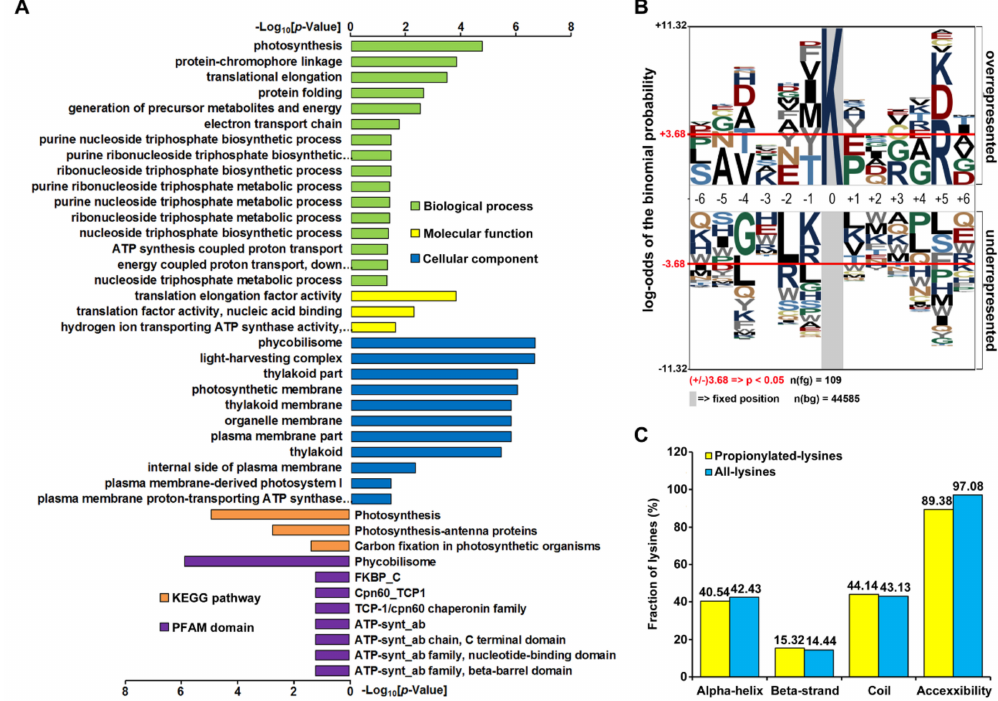
Figure 2. Enrichment analysis of propionylated proteins and bioinformatics analysis of propionylation sites. ( A ) Histogram representations of the enrichment of propionylated proteins according to their biological processes, molecular functions, cellular components, pathways, and protein family (PFAM) domains. The enrichment of GO categories, pathway, and domain were performed using DAVID bioinformatics tools (p < 0.05). ( B ) Sequence properties of lysine propionylation sites. Benjamini-corrected statistical significance values (adjusted p < 0.05) were used to control the family-wide false discovery rate. ( C ) Probabilities of localization for di ff erent secondary structures ( α -helix, beta-strand, and coil) and protein surface of identified propionylation